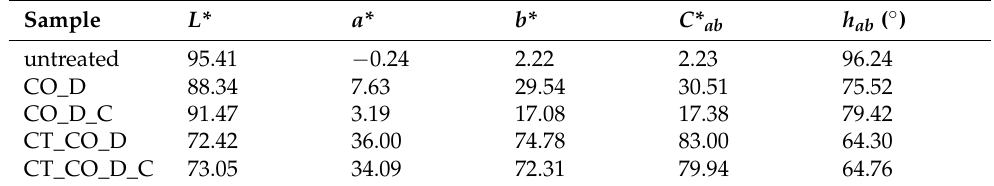
Table 3. Colour values CIELAB, chroma ( C* ab ) and hue angle ( h ab ) of undyed and dyed